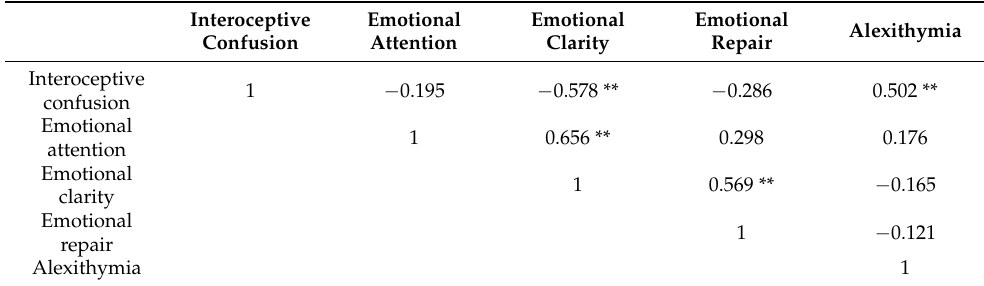
Table 2. Spearman’s correlation for the ASD